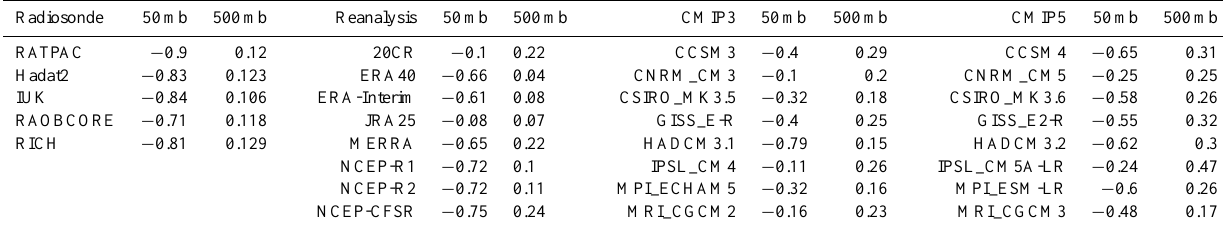
Table 2. Global mean temperature trends in the stratosphere (50hPa) and the troposphere (500hPa) in the four data set groups.